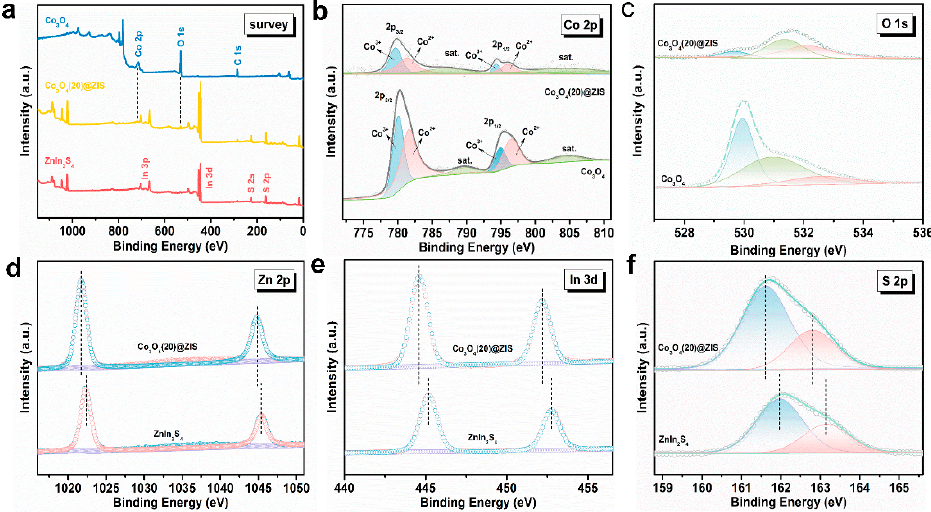
Figure 5. ( a ) General XPS images of Co 3 O 4 , Co 3 O 4 (20)@ZIS, and ZnIn 2 S 4 ; ( b ) Co 2p;.( c ) O 1s; ( d ) Zn 2p; ( e ) In 3d; ( f ) S